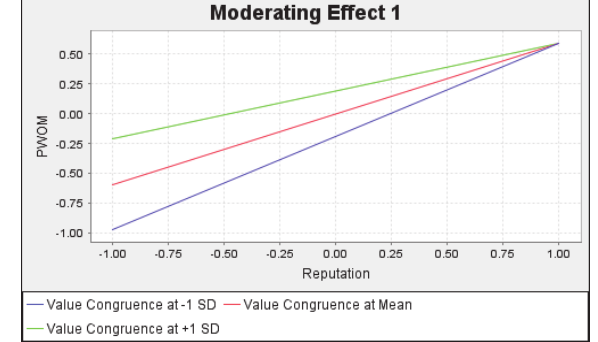
Fig. 2. Simple plot analysis for the moderating